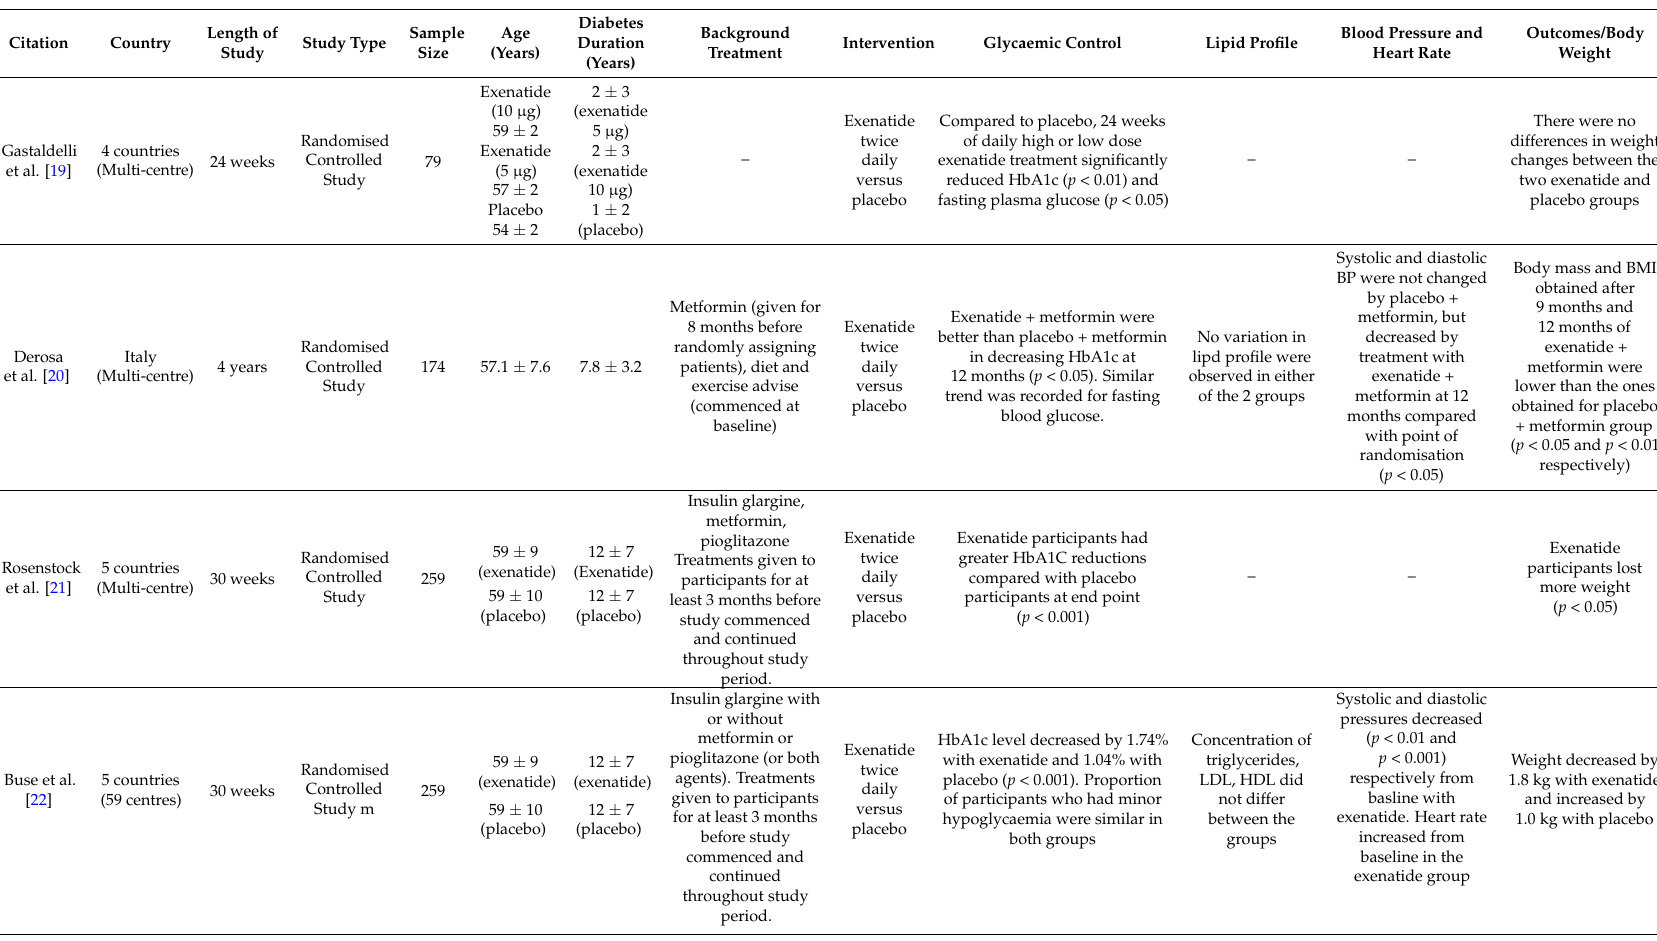
Table 1. Summary of